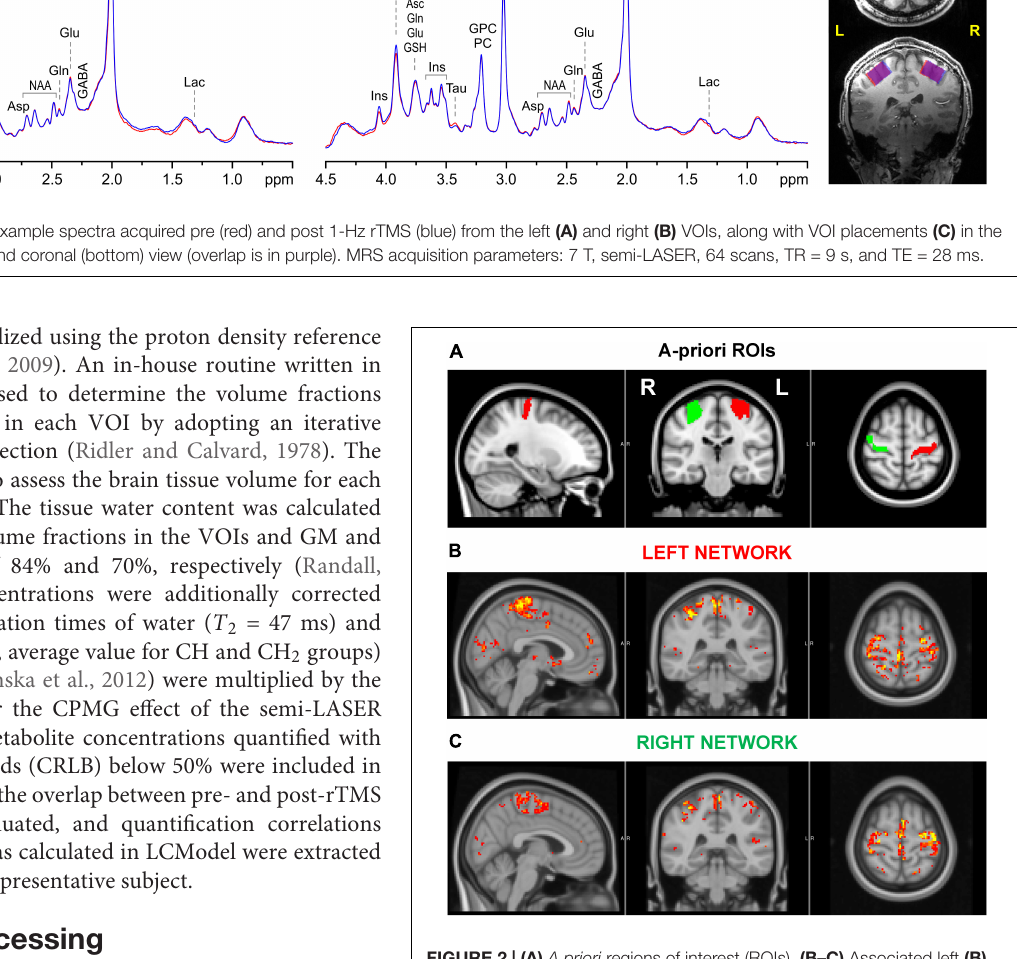
FIGURE 2 | (A) A priori regions of interest (ROIs). (B–C) Associated left (B) and right (C) motor cortex networks used in functional connectivity analyses. The ROIs encompassed the upper limb region of the precentral gyrus, as defined in the Brainnetome atlas. The displayed networks were calculated at a group level as described in the